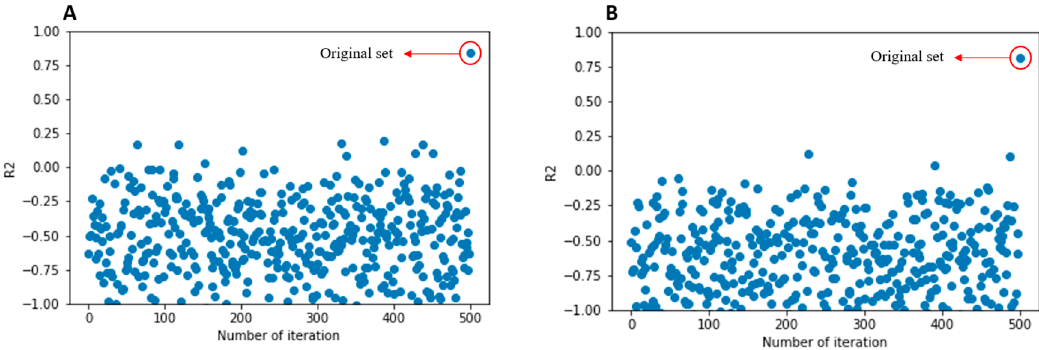
Figure 4. Y -scrambling plots for SVR_A and SVR_B models.